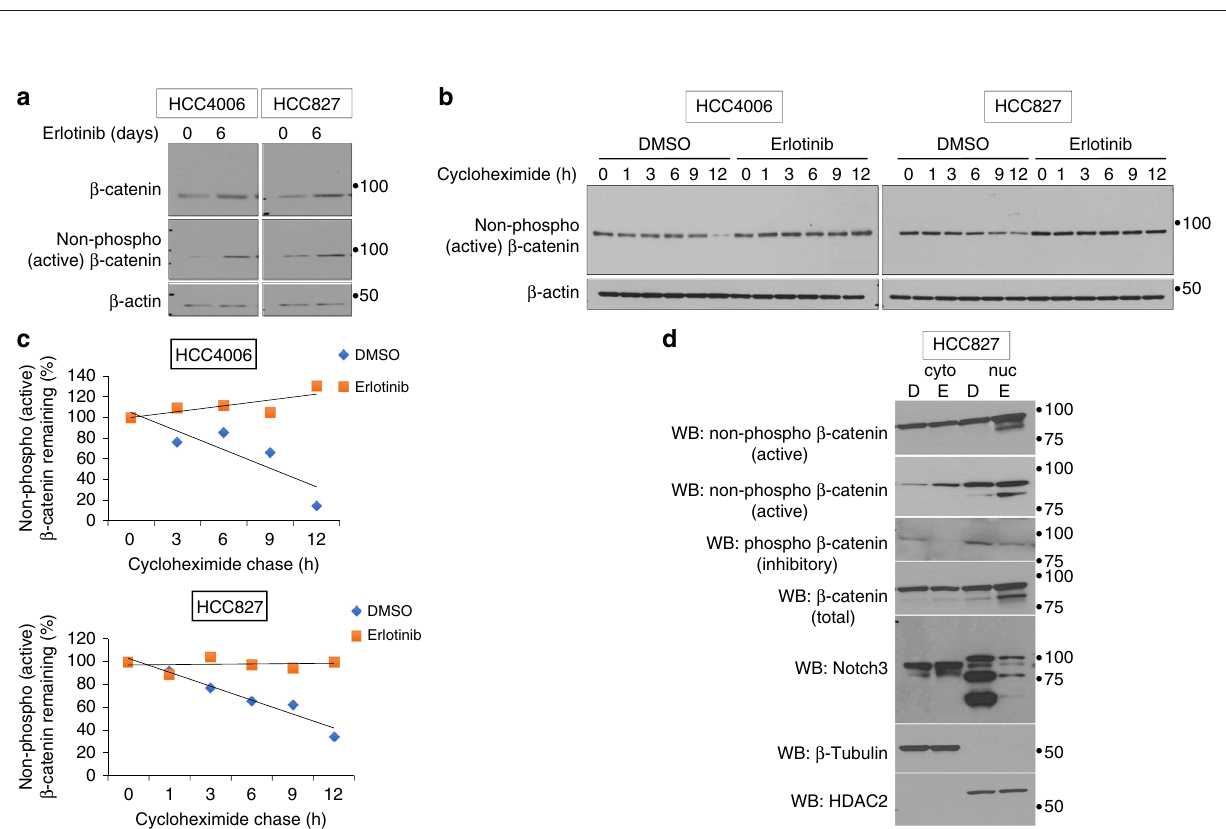
Fig. 3 Notch3 associates with β -catenin in an EGFR TKI-dependent manner. a HCC4006 and b HCC827 cells were treated with DMSO or 0.1 μ M erlotinib for 1 or 6 days and cell lysates were immunoprecipitated (IP) with an antibody recognizing Notch3 and blotted (WB) with antibodies recognizing β -catenin or Notch3. A reciprocal IP with an anti- β -catenin antibody was performed and blotted with anti-Notch3 and anti- β -catenin antibodies. c HCC827 cells were treated with erlotinib or GSI alone or in combination and cell lysates were immunoprecipitated with Notch3 and blotted with β -catenin antibody. Cell lysates were also analyzed for Notch3, β -catenin, and β -tubulin. d HCC4006 and e HCC827 cells were treated for 6 days with vehicle (DMSO) or 0.1 μ M erlotinib and stained with DAPI and probed with anti-Notch3 and anti- β -catenin antibodies. Images were overlayed to show co-localization. For ( d ) and ( e ) scale bar is 30 μ m. Error bars represent SD from technical triplicates